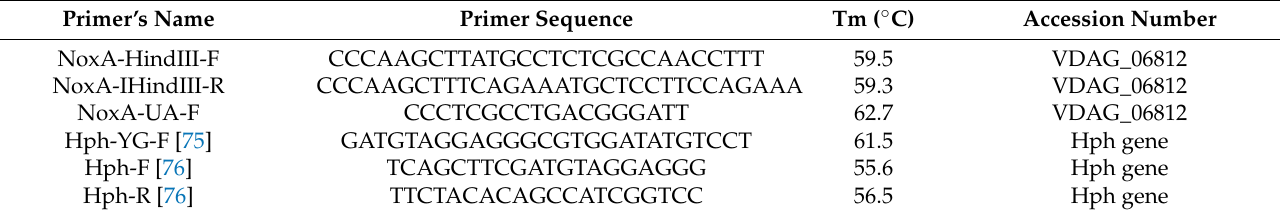
Table 1. Primers used in generating mutants for Nox family